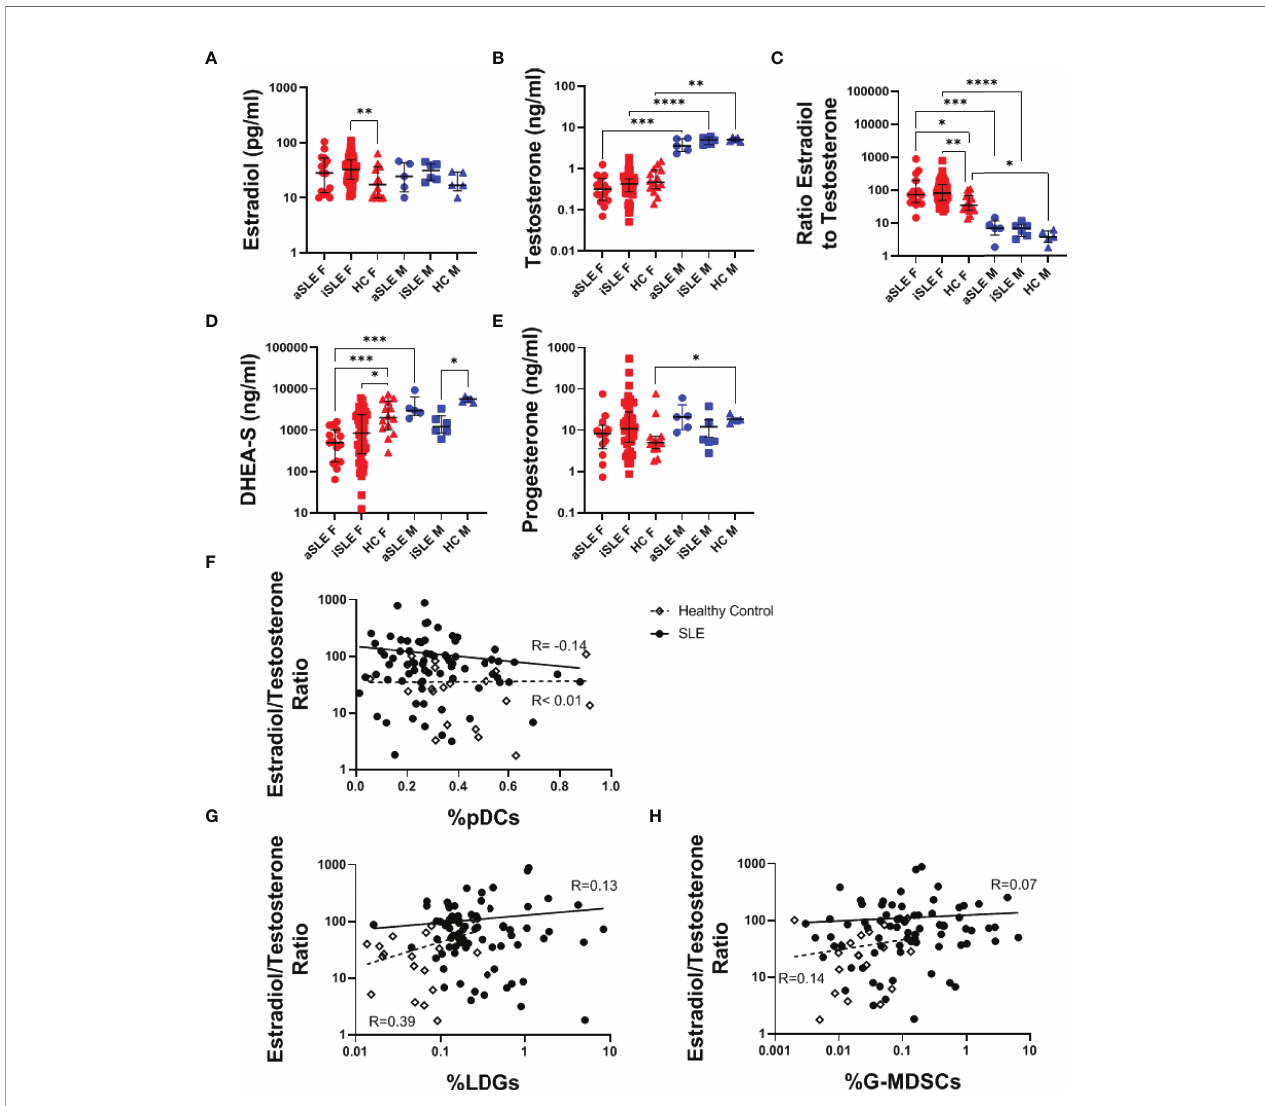
FIGURE 2 | Female SLE patients have distinct hormonal pro fi les. Serum samples were analyzed via ELISA for levels of (A) Estradiol, (B) Testosterone, (D) DHEA-S, and (E) Progesterone. (C) The ratio of estradiol to testosterone was also analyzed and found to be increased among both males and females with SLE. Comparisons were made using Kruskal-Wallis Test with Dunn ’ s test for multiple comparisons. Bars represent median and interquartile range. The estradiol/ testosterone ratio did not signi fi cantly correlate to expression of (F) pDCs, (G) LDGs, or (H) G-MDSCs. aSLE F (N = 15), iSLE F (N = 50), HC F (N = 14), aSLE M (N = 5), iSLE M (N = 6), HC M (N = 5). *p < 0.05; **p < 0.01; ***p < 0.001; ****p <